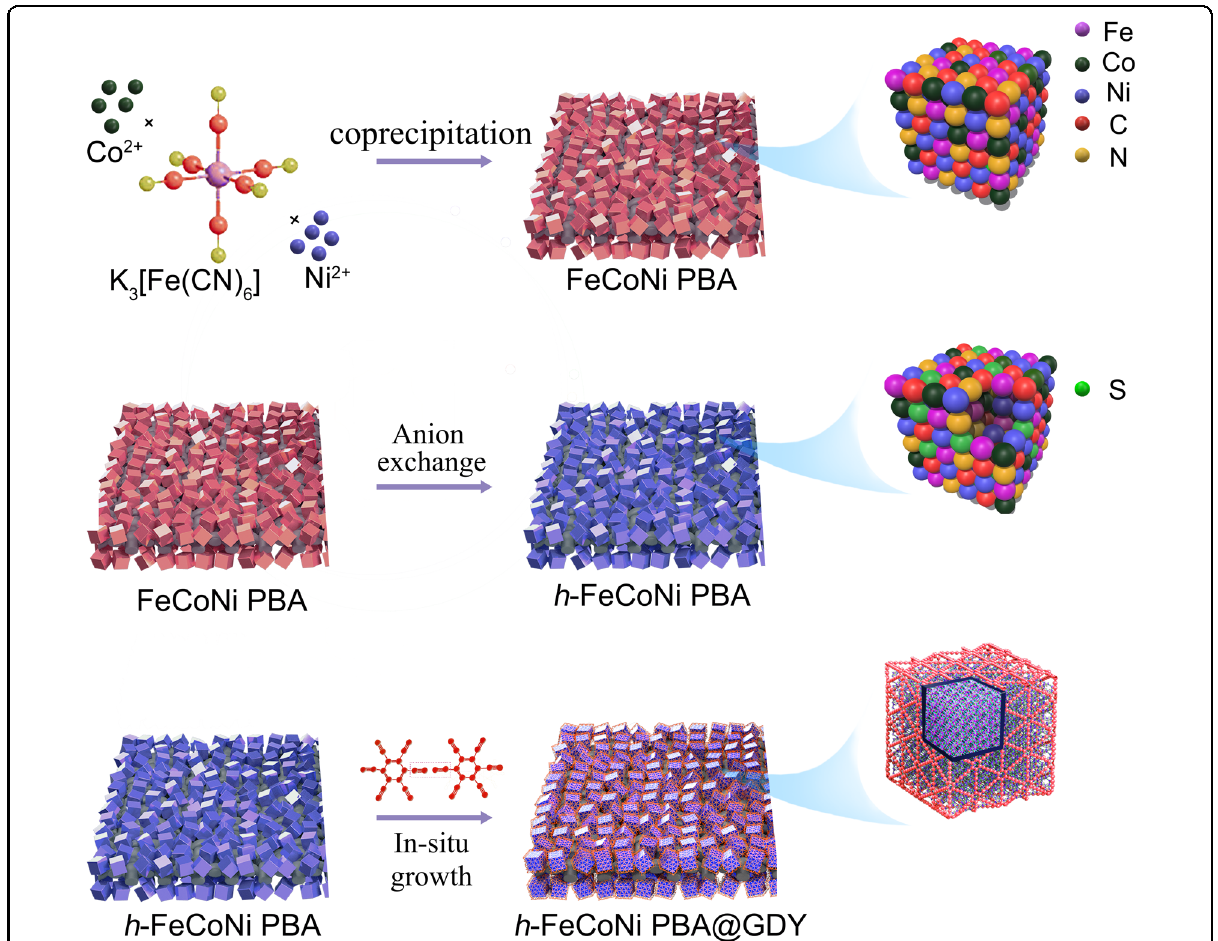
Fig. 1 Schematic illustration of the synthetic routes. The multistep reactions to synthesize h -FeCoNi PBA@GDY involved the coprecipitation of FeCoNi PBA, anion exchange synthesis of h -FeCoNi PBA, and in-situ growth of GDY to form h -FeCoNi